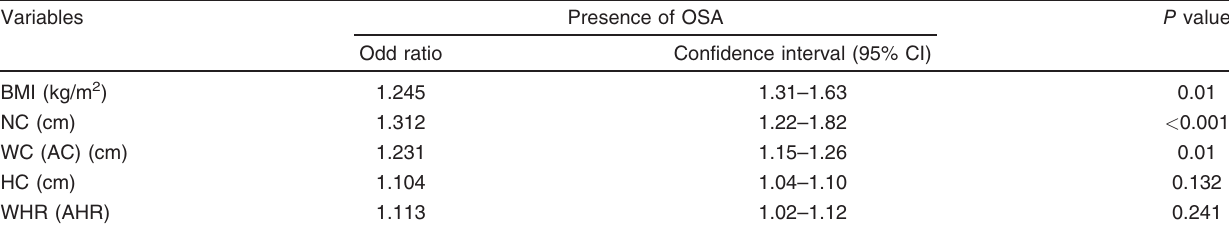
Table 5 Evaluation of the correlation and significance of the individual (univariate) anthropometric indices for diagnosis of obstructive sleep apnea Variables